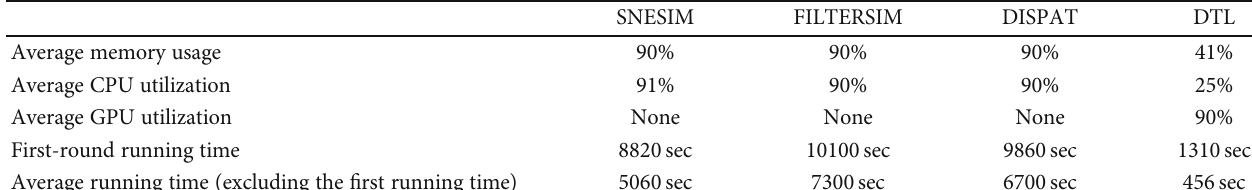
Table 9: The average memory usage, CPU/GPU utilization, and running time of SNESIM, FILTERSIM, DISPAT, and DTL for 10 reconstructions (sandstone).